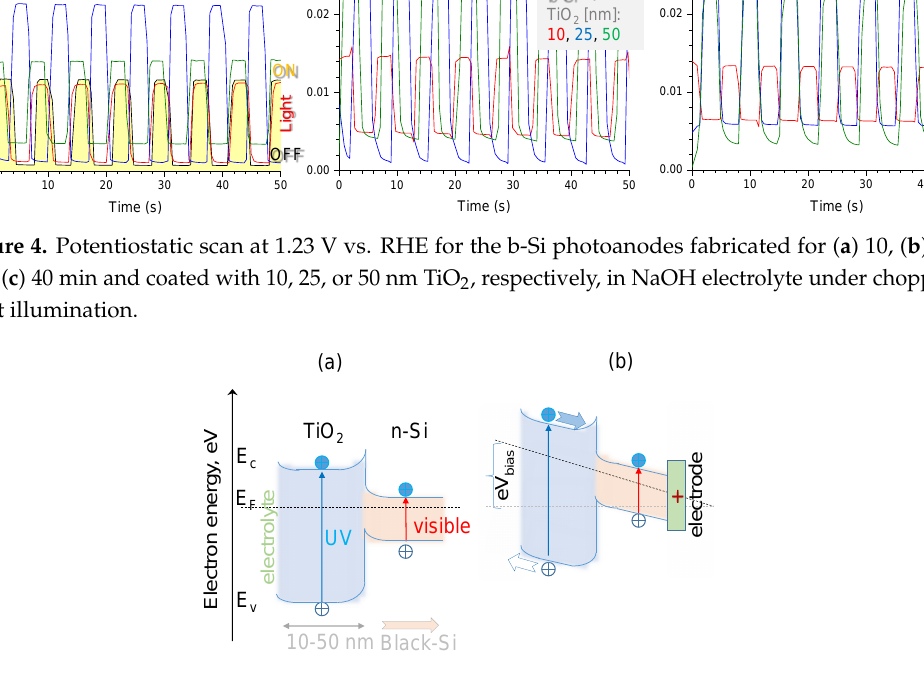
Figure 5. Band diagram of n-n junction between Si and TiO 2 without ( a ) and with ( b ) bias. B-Si was fabricated using n-type Si. Under positive bias, holes drift to the titania-solution interface while electrons are drawn into the electrode bulk. The bandgap of TiO 2 is 3.1 eV (400 nm) and 1.12 eV for Si. Under a white light (spectrally broad) illumination, e-h generation occurs at both the materials forming a TiO 2 -Si n-n-junction. Arrows show e,h drift